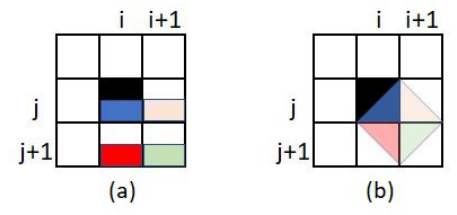
Figure 7. Constructing a rotated block from four neighboring cells. The summation of the weights of the four half cells shown on subfigure ( a ) is equal to the weight of the rotated block shown in subfigure ( b